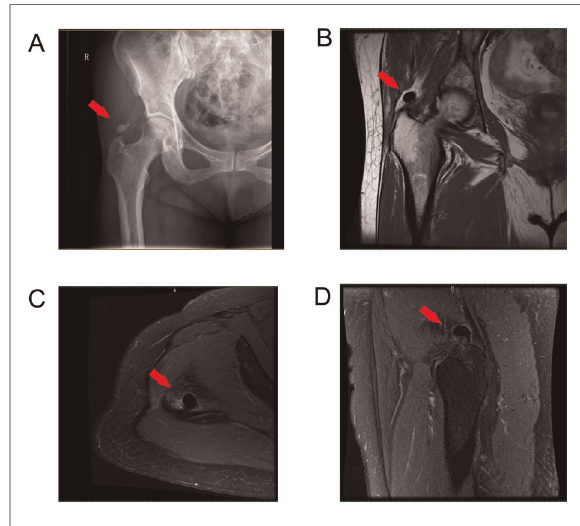
FIGURE 1 ( A ) Preoperative plain radiograph, ( B ) T2 coronal, ( C ) T1 horizontal, and ( D ) T1 coronal. View of MRI showing the calci fi cation around the tip of the right greater trochanter (marked with